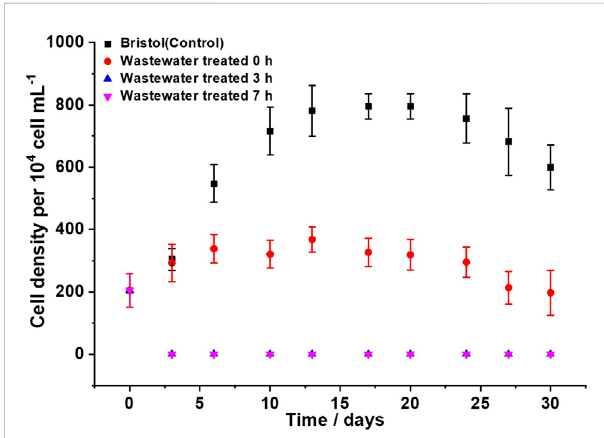
FIGURE 6 Growth curves of Chlorella sp . culture in Bristol medium, domestic wastewater, and domestic wastewater treated by electro- oxidation for 3 and 7 h.